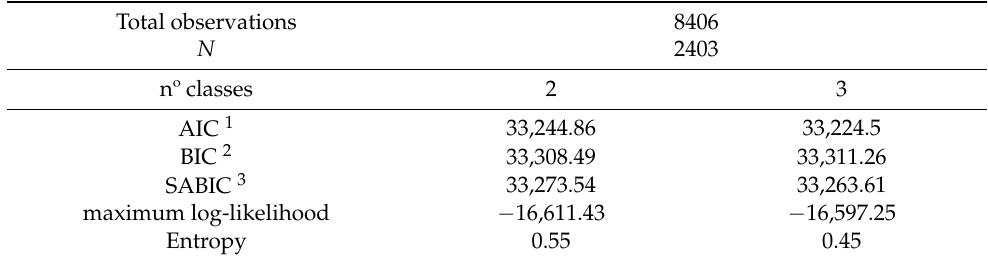
Table 1. Fit statistics for the grow mixture models of cognitive trajectories from ZARADEMP